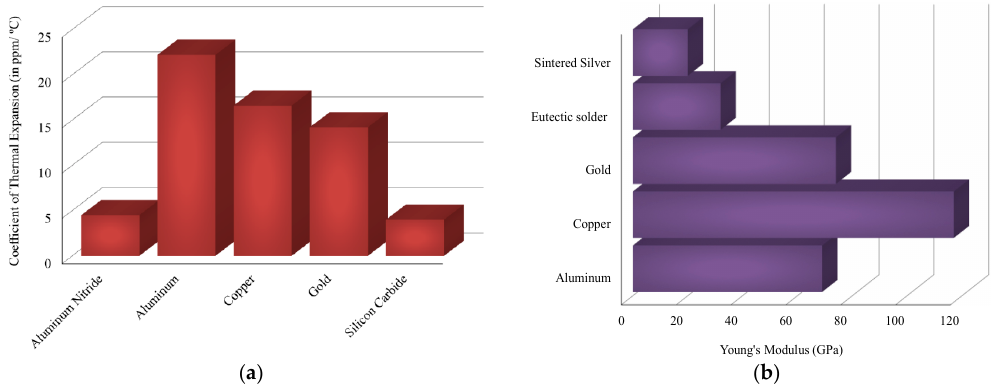
Figure 7. A bar graph comparing the ( a ) coefficient of thermal expansion (CTE) and ( b ) Young’s modulus of materials used in a state-of-the-art SiC power module.